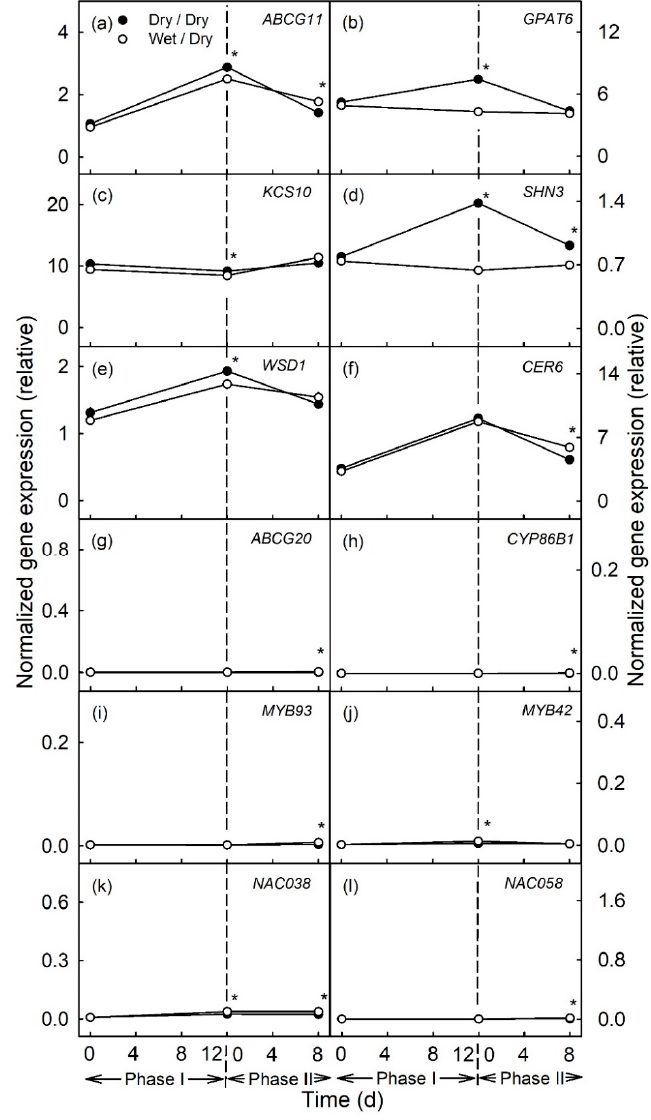
Figure 4. Time course of expression of genes related to cutin and wax synthesis ( a – f ) and to suberin and lignin synthesis ( g – l ) of apple fruit skin during exposure to moisture (Phase I) and after exposure to moisture was discontinued (Phase II). During Phase I, a patch of the fruit skin was exposed to moisture for 12 d beginning at 93 days after full bloom (DAFB) (wet). During the subsequent Phase II, moisture was removed, and the patch was exposed to the atmosphere (dry). Moisture exposed patches of fruit skin are referred to as wet/dry, unexposed control patches as dry/dry. The end of the moisture exposure is indicated by the vertical dashed line. The expression values are means ± SE of three independent biological replicates comprising ten fruit each. The ‘*’ indicates significant differences between dry/dry and wet/dry at p ≤ 0.05 (Student’s t -test).